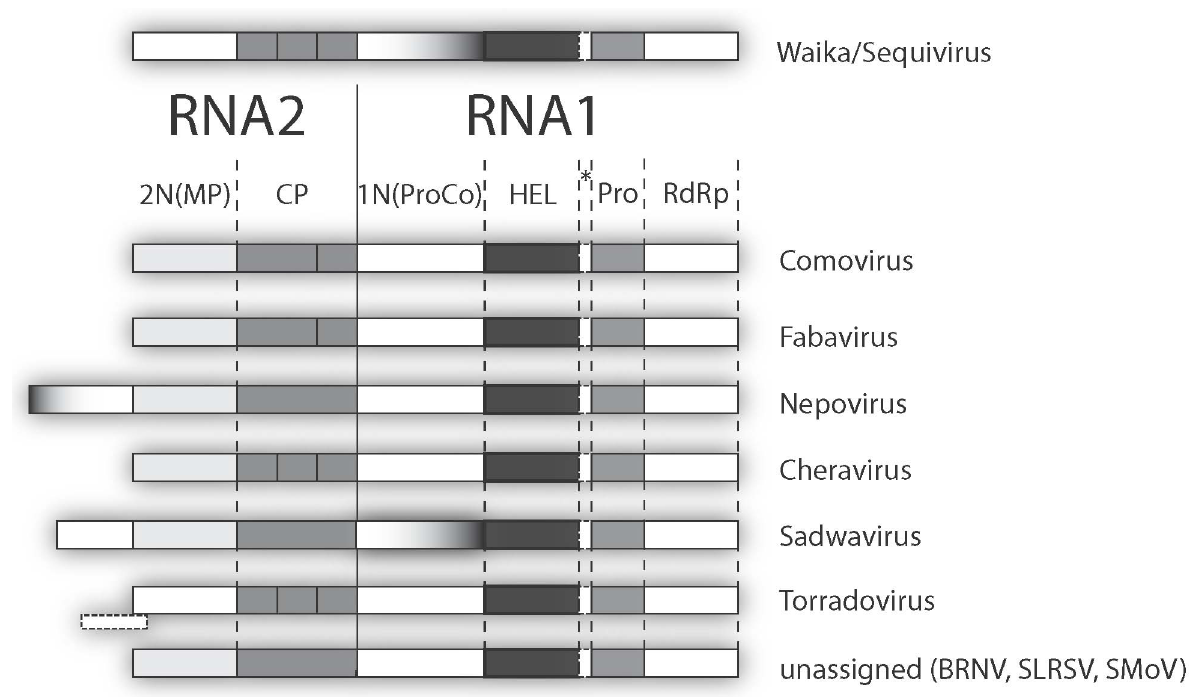
Figure 1. Simplified schematic of the genomic organization of the Secoviridae . The names of eight taxa are indicated on the right of the depicted genomes. The monopartite genomes of the waikaviruses and sequivirus are diagrammed at the top from left to right in a 5’ to 3’ direction. Only the protein-encoding regions are shown, delineated as shaded rectangles. The remaining taxa/genera have bipartite genomes. The functional domain order in the two RNAs is conserved and they are displayed with the RNA2 on the left, separated from the RNA1 by a solid vertical line. This arrangement allows the coding regions of the bipartite viruses to be aligned with the monopartite genomes. The functional regions from left to right are: the putative movement protein or 2N terminal protein 2N(MP), the coat protein (CP), the putative protease cofactor or 1N terminal protein 1N(ProCo), the helicase (HEL), the protease (Pro) and the RNA-dependent RNA polymerase (RdRp). Putative additional N-terminal genes are shown with dotted borders for the genera Nepovirus (of various sizes depending on subgroup), Sadwavirus and Torradovirus . The existence of a translation product or function for the latter virus has still not been demonstrated and was thus excluded from the analyses. * indicates the putative 5’-genome- linked protein (VPg). Black raspberry necrosis virus (BRNV), Strawberry latent spherical virus (SLRSV), Strawberry mottle virus (SMoV).